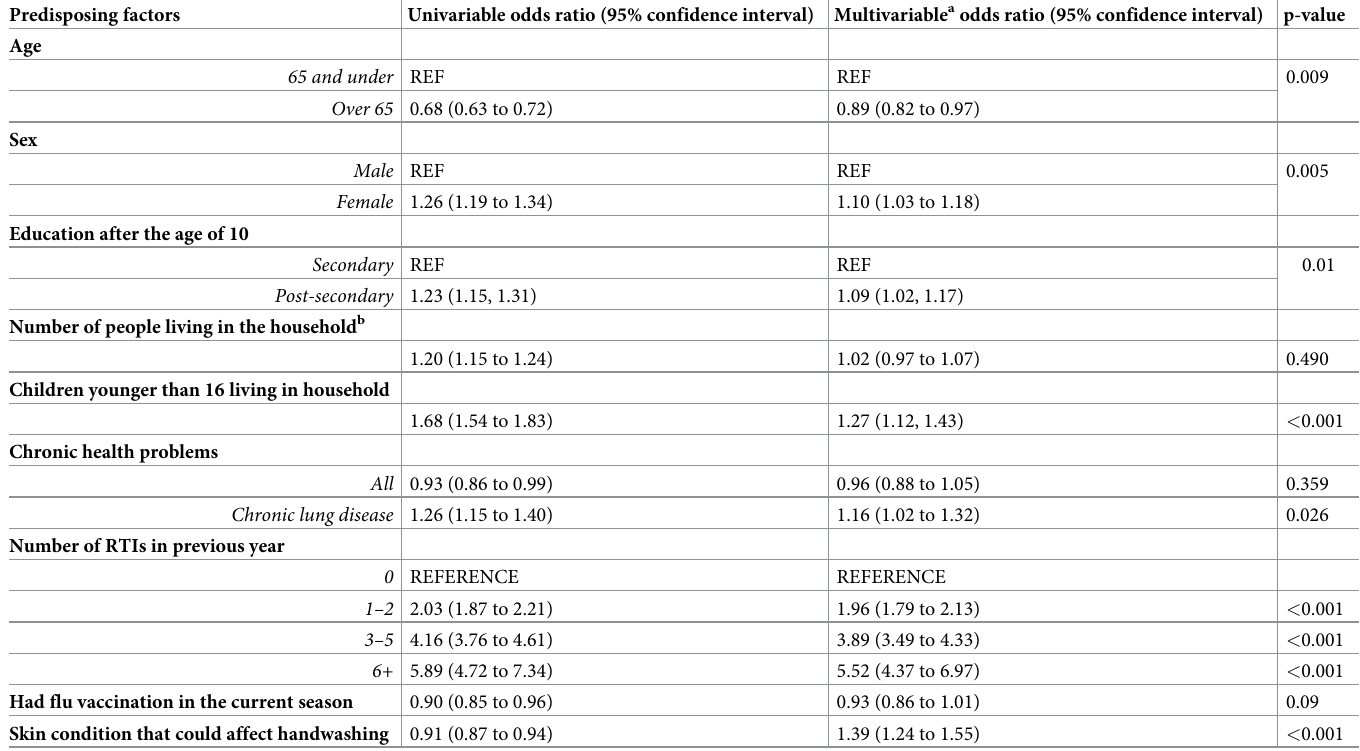
Table 2. Crude and adjusted odds ratios for risk factors associated with acquisition of a respiratory infection during 16-week PRIMIT study period. Predisposing factors